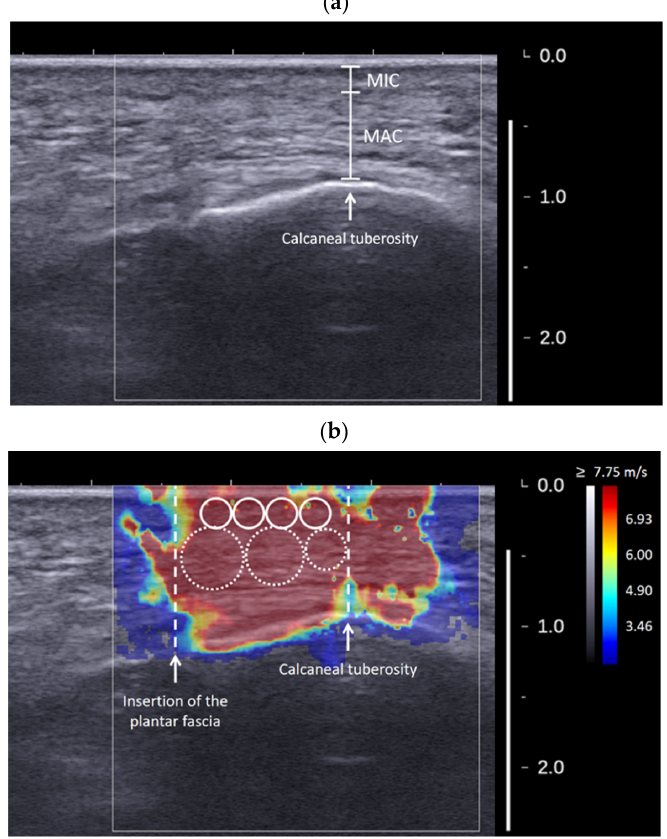
Figure 4. Illustration of the measurement methods for the shear wave speed ( a ) and thickness ( b ) of the microchamber (MIC) and macrochamber (MAC) layers of the heel pad.